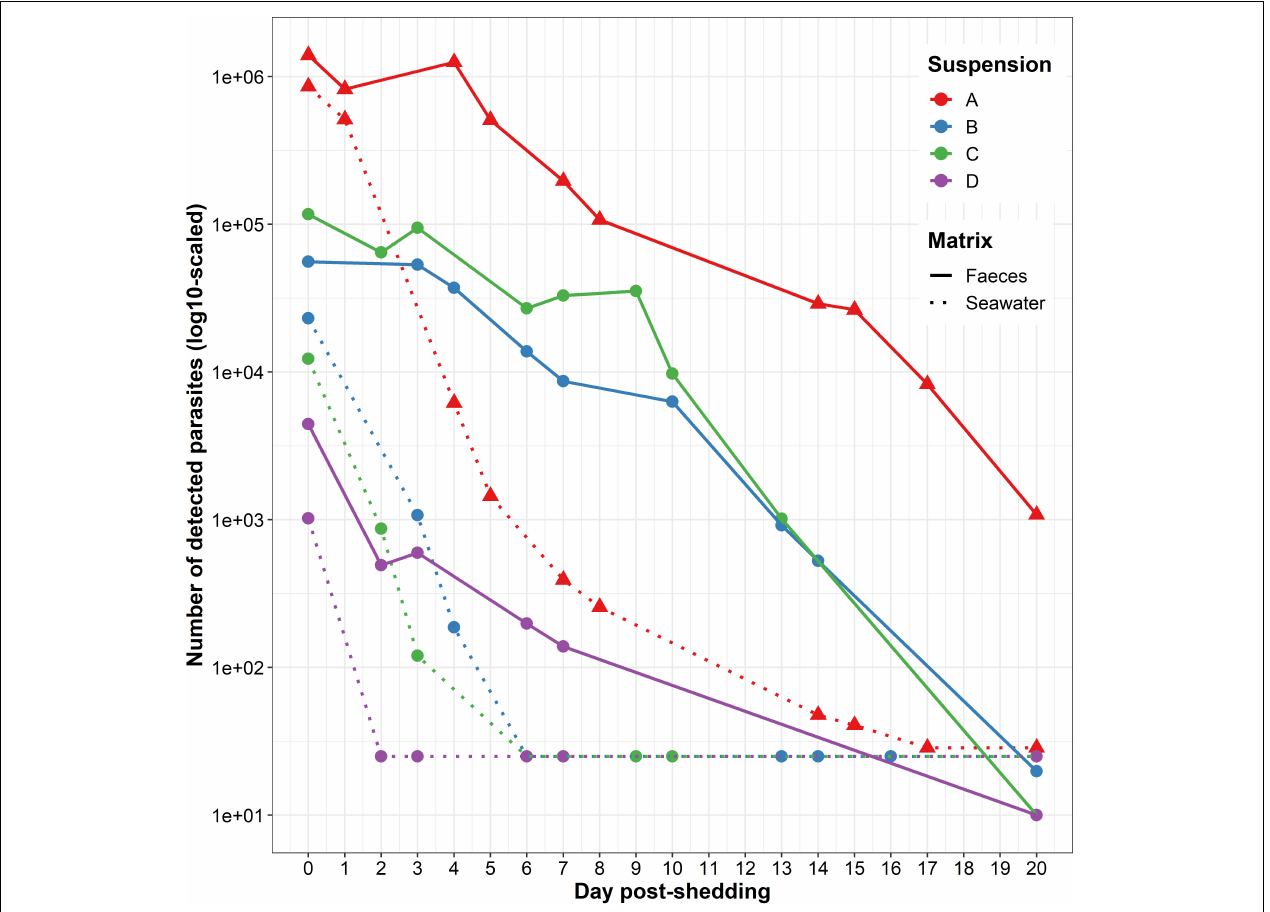
FIGURE 2 | Marteilia refringens DNA detection in the four tested seawater (dotted lines) and faeces (solid lines) suspensions (A–D). Samples of seawater and faeces were collected every 1–5 days during 20 days after removing flat